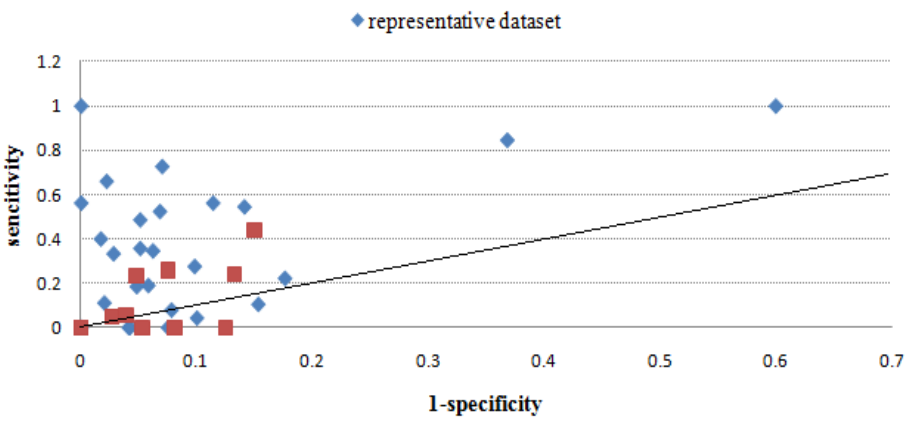
Figure 6. Sensitivity vs. 1-specificity scores of EpiSearch on the benchmark dataset and the representative